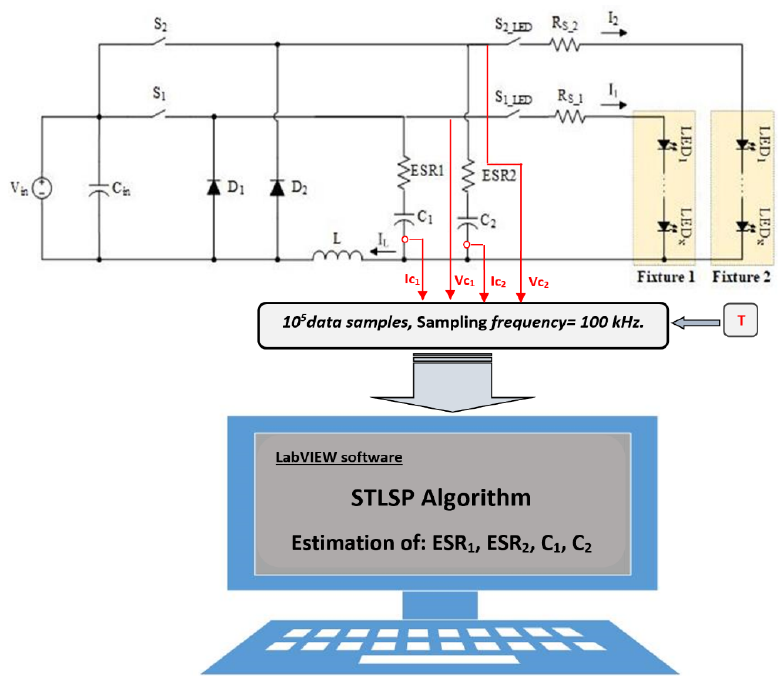
Figure 4. LED driver